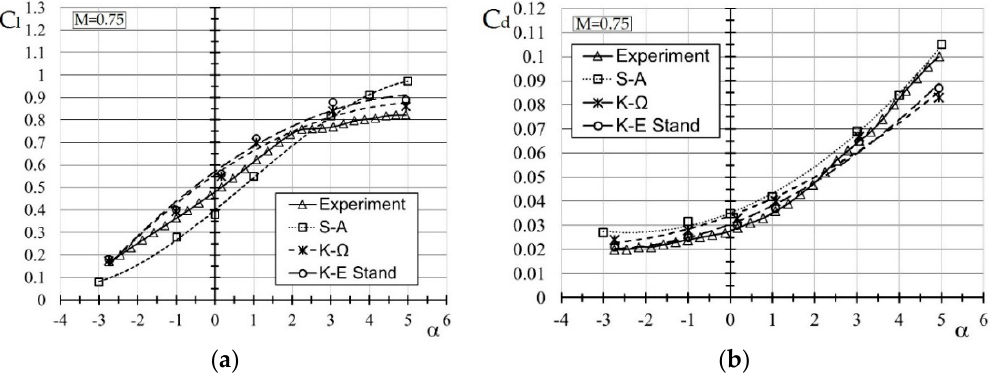
Figure 6. ( a ) Comparison of computed DLR-F4 lift coefficient for different turbulence models with wind tunnel experiment results at M = 0.75 and Re = 3 × 10 6 ; ( b ) Comparison of computed DLR-F4 drag coefficient with experimental results at M = 0.75 and Re = 3 × 10 6 .